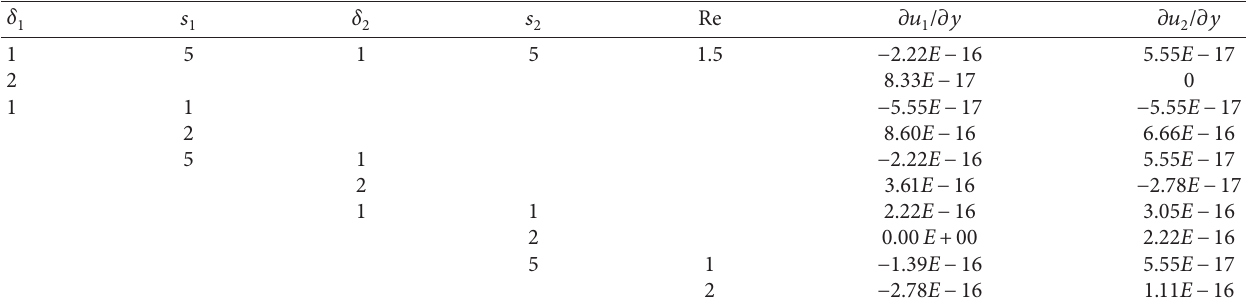
Table 2: The rate of shear stress coefficients at the lower and upper plates,